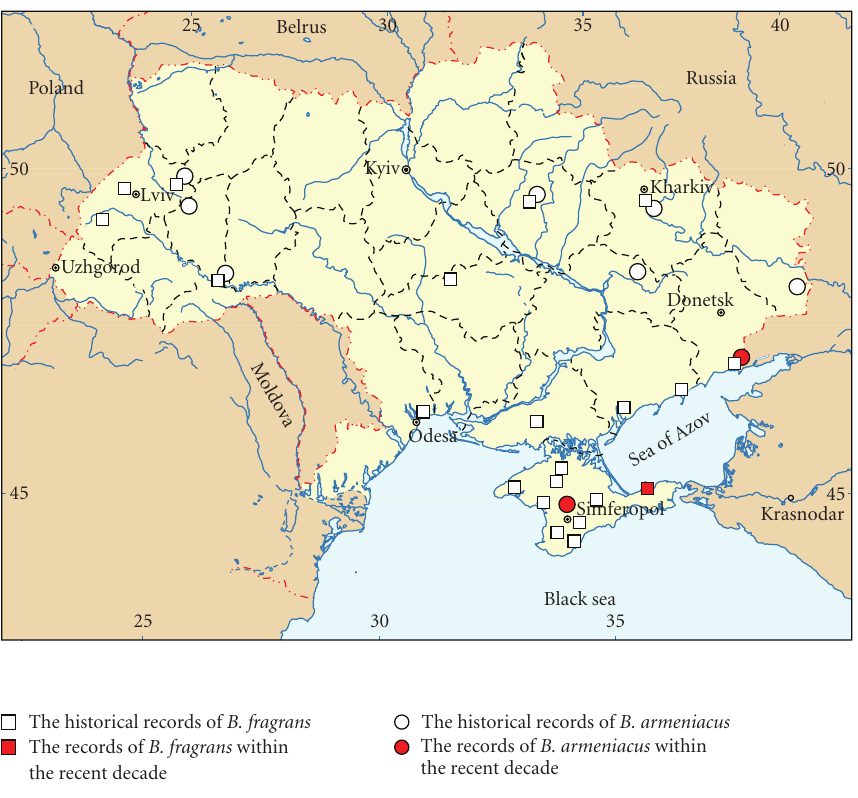
Figure 2: The distribution of B. fragrans and B. armeniacus in Ukraine (the records made since